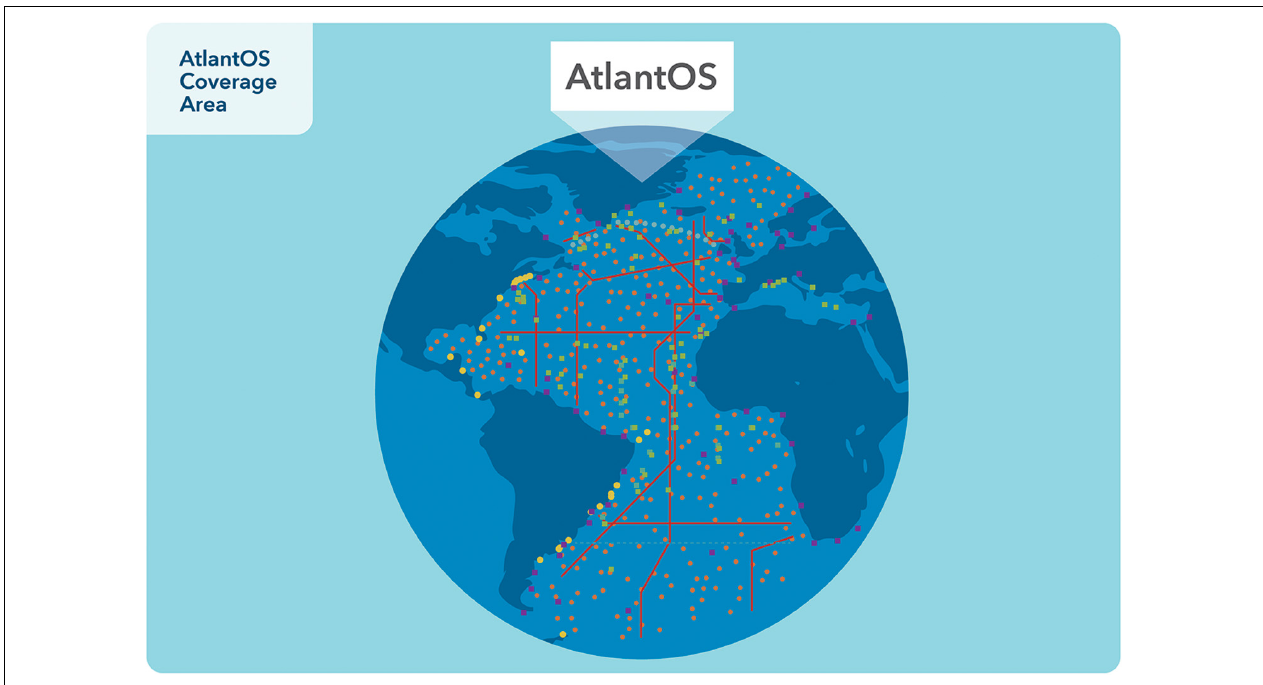
FIGURE 1 | AtlantOS coverage area. The Atlantic Ocean, depicting the focus area of ocean observing for AtlantOS. Dots and lines conceptually indicate current ocean observing activities by major networks, such as Argo, GO-SHIP, PIRATA, and OSNAP.